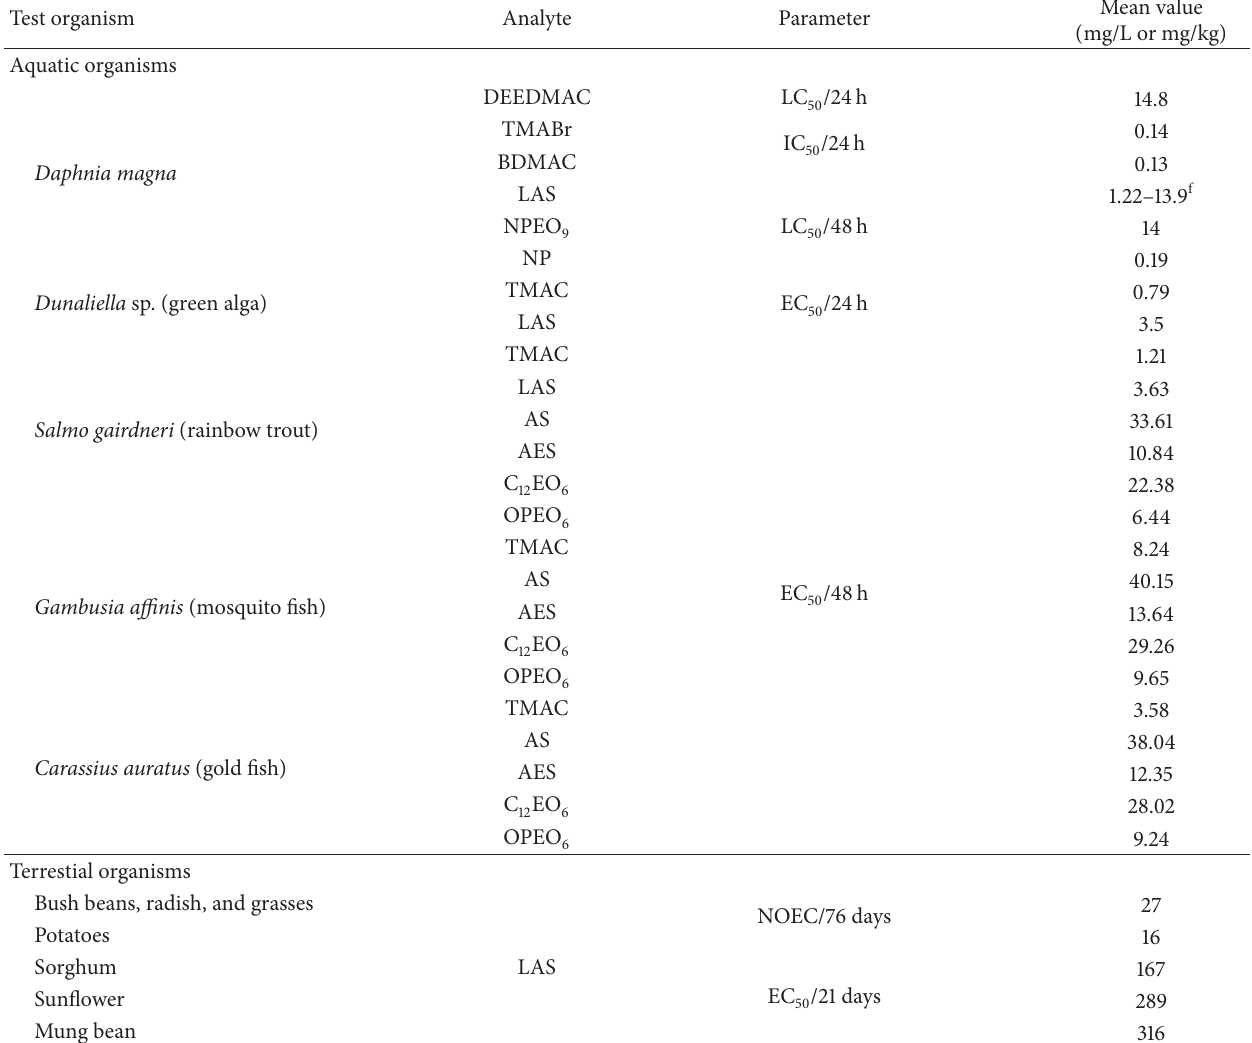
f Data for different homologues of LAS